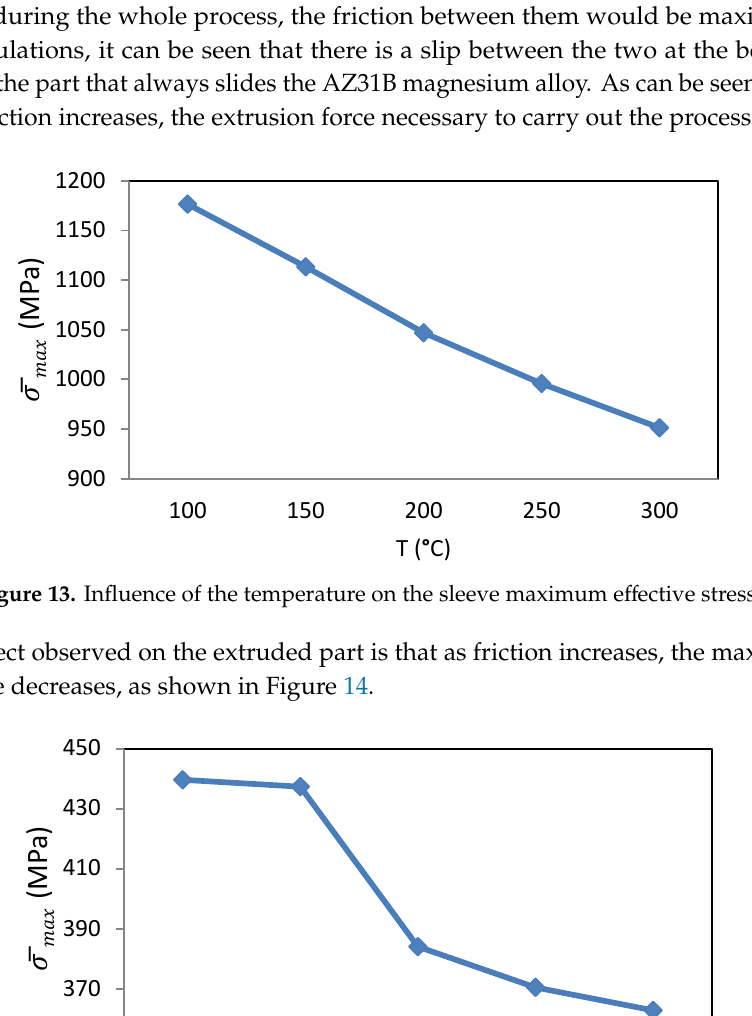
Figure 12. Influence of the temperature on the core maximum effective stress.